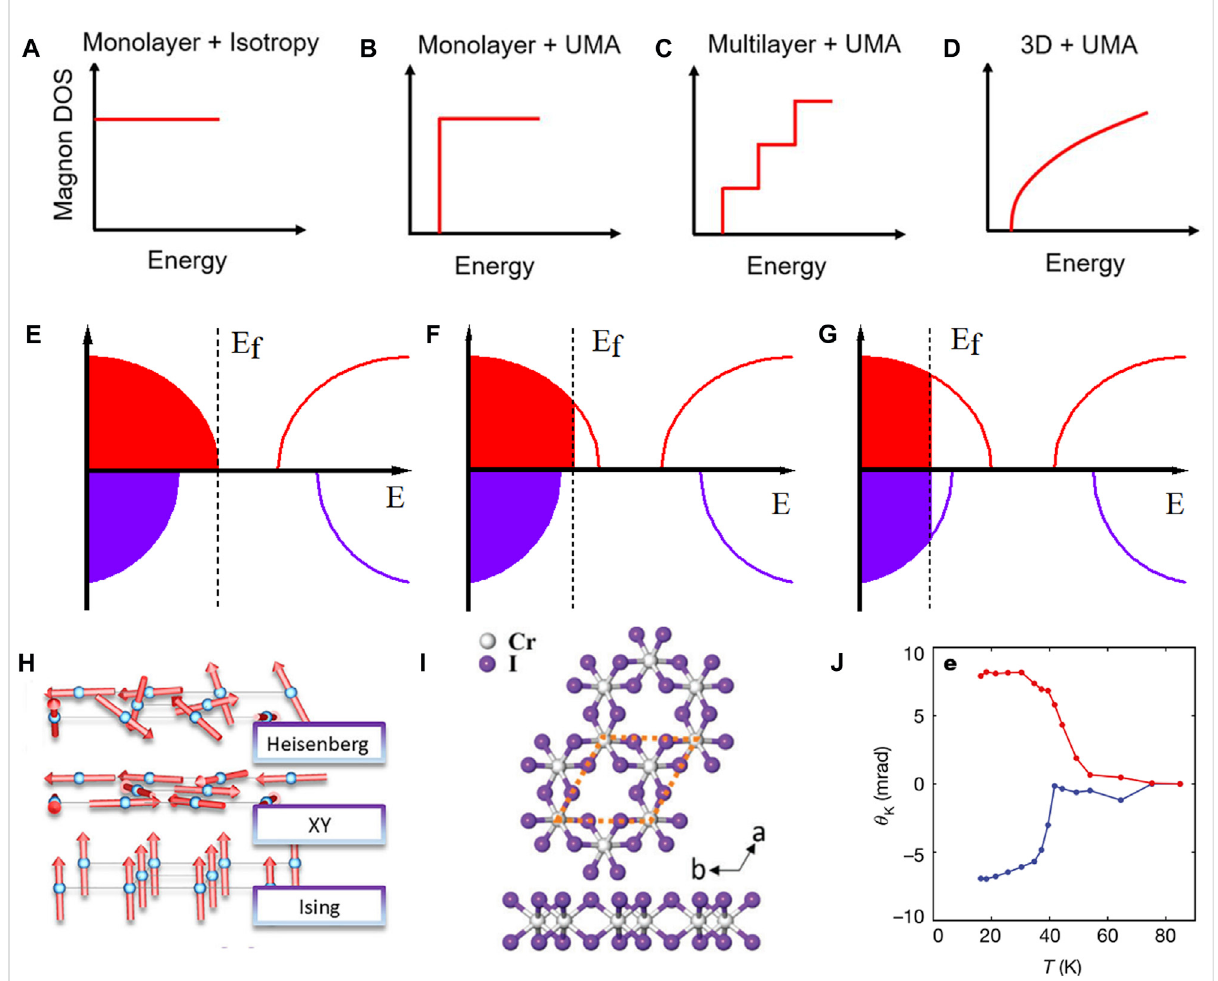
FIGURE 1 (A – D) Spin wave excitations in ferromagnets of different dimensionalities Reproduced with permission [6]. Copyright © 2019 American Association for the Advancement of Science (AAAS). (E – G) Schematic DOS for three types of ferromagnetic semiconductor, half-metal, and metal materials. (H) Spin symmetries of MA for Heisenberg model, XY model, and Ising model, respectively. Reproduced with permission. Copyright © 2020 John Wiley and Sons Australia. (I) The structure of CrI 3 monolayer. (J) Polar MOKE signal for a CrI 3 monolayer. Reproduced with permission [1]. Copyright © 2017 Springer